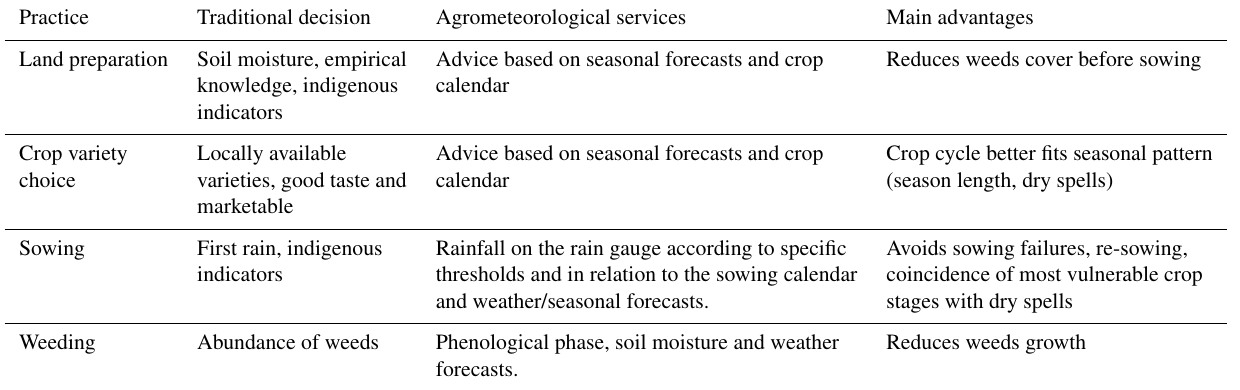
Table 2. Traditional vs. informed decision-making.